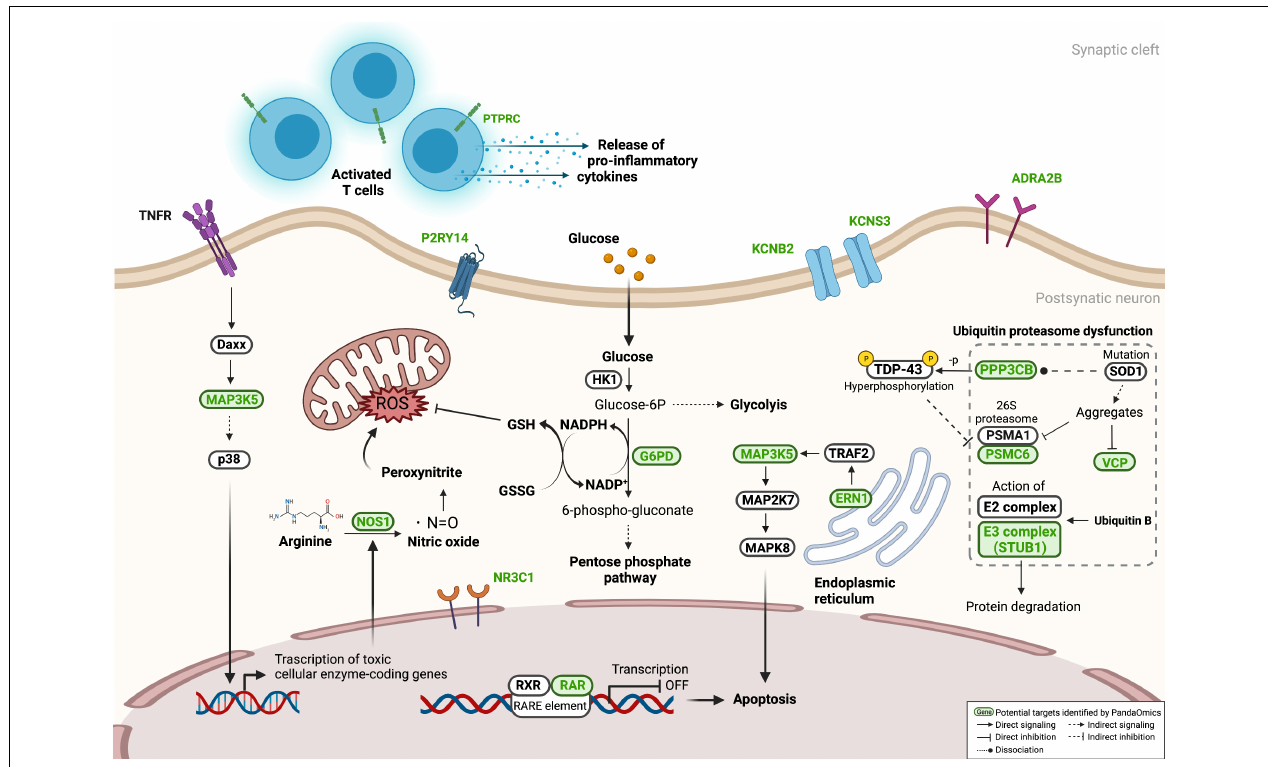
FIGURE 5 | Proposed targets in ALS-associated pathways. Several proposed targets, labeled in green, were presented in pathways related to ALS pathogenesis, including neuronal cell death, oxidative stress, neuroinflammation, and proteostasis dysfunction. Information of associated networks was retrieved from KEGG ALS pathway (map05014), Protein processing in endoplasmic reticulum (map04141), T cell receptor signaling pathway (map04660), Ubiquitin mediated proteolysis (map04120), and Pentose phosphate pathway (map00030).